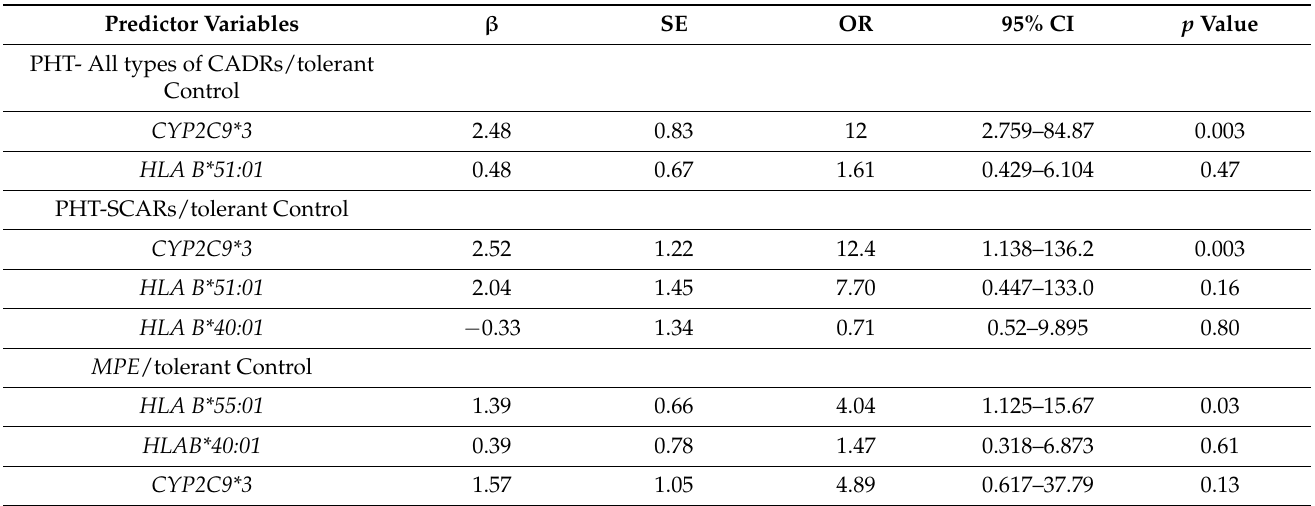
Table 4. Multivariate binary logistic regression analysis of PHT-CADRs and tolerant-control. Predictor